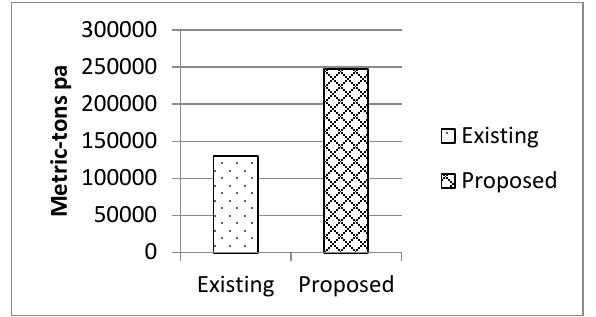
Figure 11 . Comparison of solid waste generated.